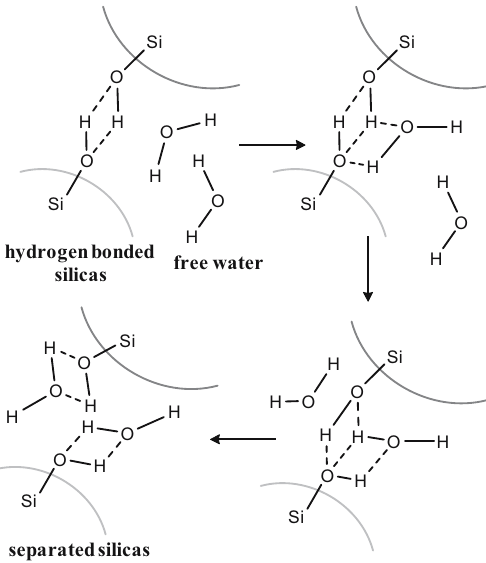
Figure 7: “ Dissolution ” of aggregates by free water after mixing with